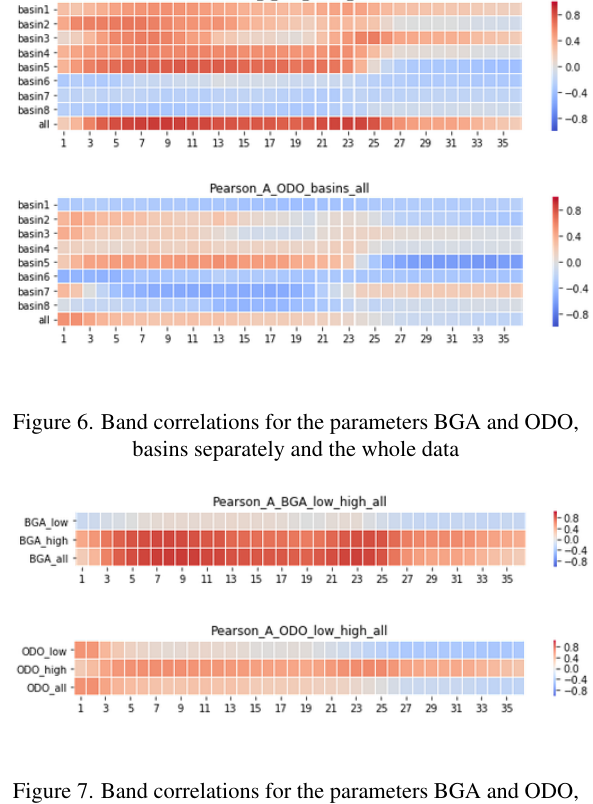
Figure 7. Band correlations for the parameters BGA and ODO, parameter classes separately and the whole